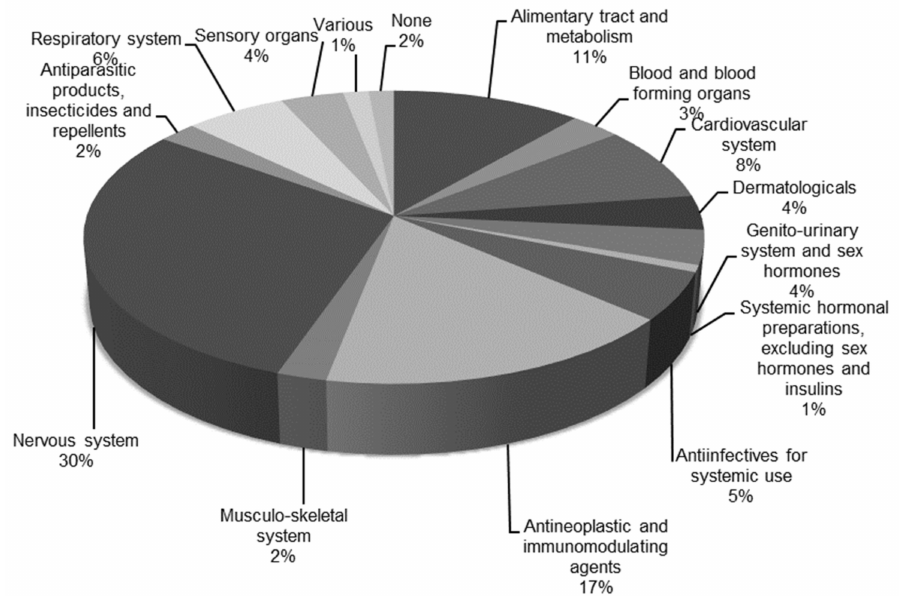
Figure 2. Distribution of prioritized drugs across the Anatomical Therapeutic Chemical (ATC) Classification System groups. Drugs that bind to a nuclear receptor as their mode of action were excluded. Total number of drugs represented in this figure is 130.